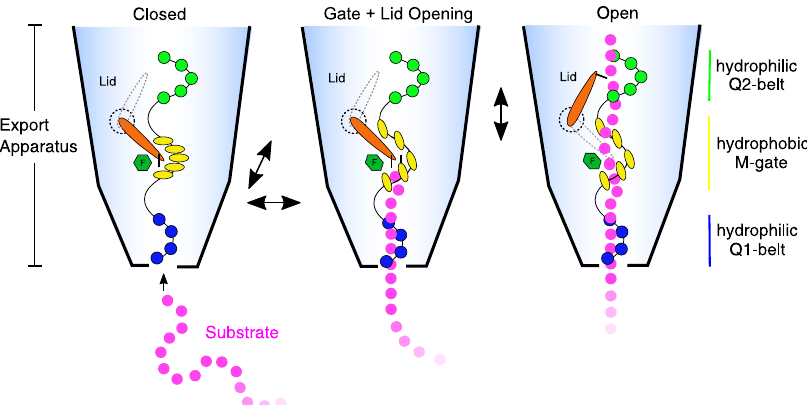
Fig. 7 Model for substrate translocation through the EA of T3SSs. Disordered N-termini of effector proteins (magenta circles) enter the Q1-belt (blue circles) of the EA facing the bacterial cytoplasm. Successive binding of the substrate backbone to conserved glutamines facilitates penetration through the Q1-belt and loading of the substrate into the needle complex. The substrate then penetrates the M-gate. Disruption of its hydrophobic interface (Met186- Met187: yellow ovals; SpaR Phe212: green hexagon) expands the gate and causes the SpaR loop (orange) to fl ip into a vertical position together generating a narrow path for the translocation of the unfolded substrate chain. The substrate then proceeds up to the Q2-belt (green circles) and SpaR loop (orange; Ile114 represented as black tick), which together stabilize the substrate above the M-gate and support substrate transport towards the atrium and needle fi lament to ultimately facilitate effector protein